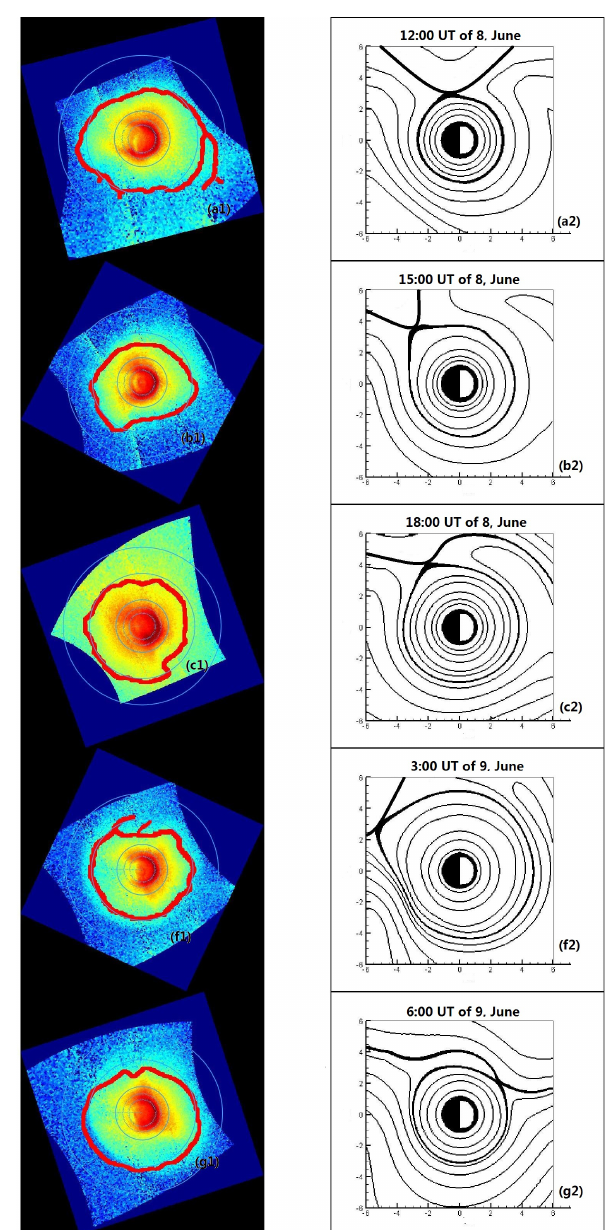
Figure 4. The subscript of panels correspond to Fig. 3. The left col- umn of panels shows original observation results by EUV/IMAGE; the blue circles on the panels correspond to L = 1, 2, 4, and 6. The right column of panels shows equipotential lines in the equatorial plane; the last closed equipotential (LCE) is the bold black